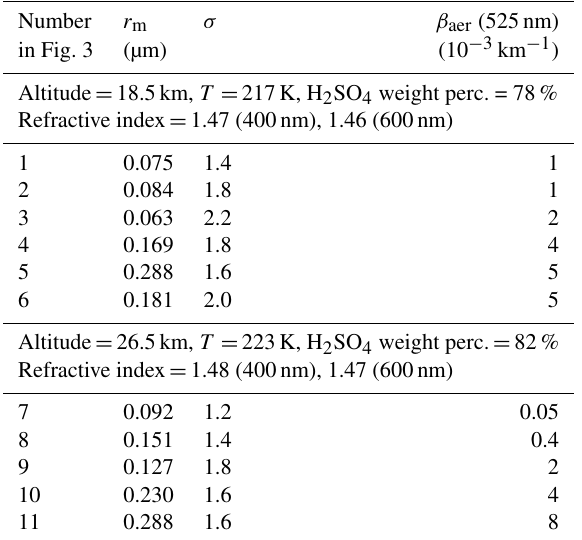
Table 3. Stratospheric aerosols: lognormal particle size distribution parameters r m (mode radius) and σ (mode width), and aerosol ex- tinction β aer at 525nm, representative of the period just before and after the Pinatubo eruption, at two different altitudes, in the 30– 50 ◦ N latitude band. The data were derived from Figs. 4, 8 and 11 of Bauman et al. (2003). A few calculated refractive indices are also